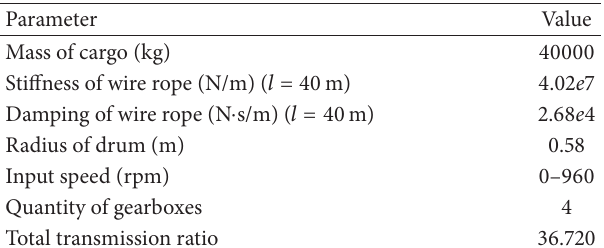
Table 1: Design parameters of hoisting mechanism.